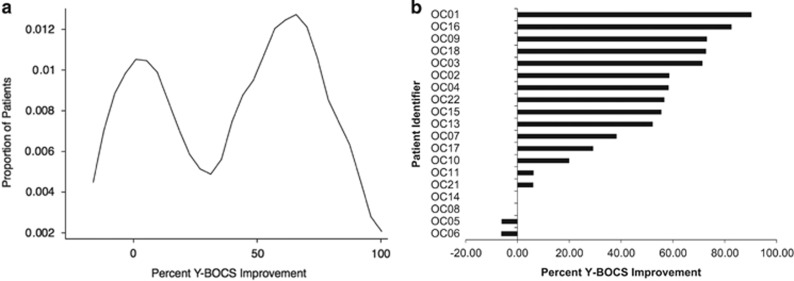
Probability distribution function (a) and ranked individual-patient plot (b) of treatment outcomes for dmPFC-rTMS in OCD. A bimodal distribution of treatment outcomes is evident, suggesting distinct responder and nonresponder subpopulations within the patient sample. Outcomes are calculated as percent improvement in YBOCS scores from pre- to post-treatment. One subject was a non-completer (14 rTMS sessions performed).